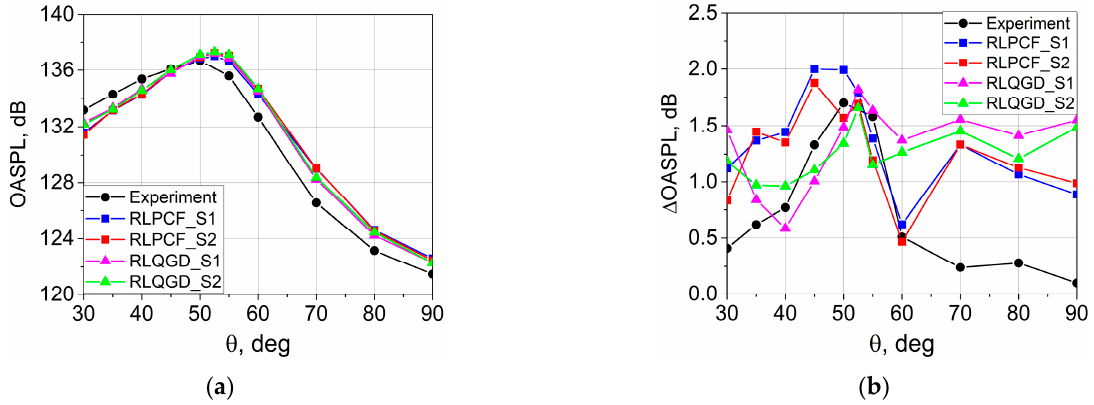
Figure 11. Directivity plot comparing noise fields of the ideally expanded jet: ( a ) OASPL in dB; ( b ) reduction of the OASPL at each angle.